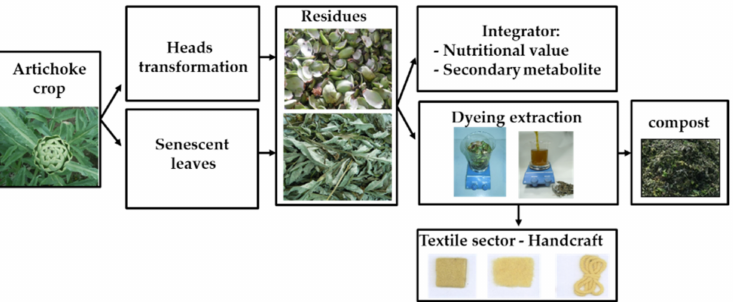
Figure 1. Flowchart of the recovery of artichoke cultivation and processing residues Bianco of